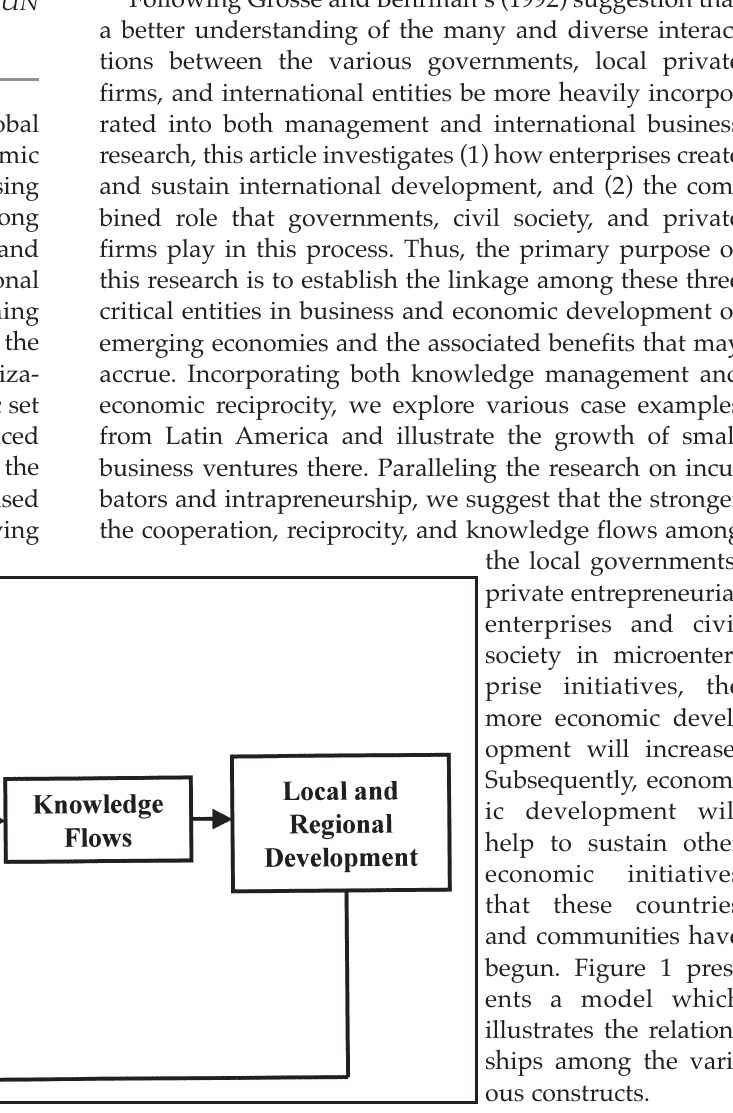
Figure 1. Triad Collaboration and International